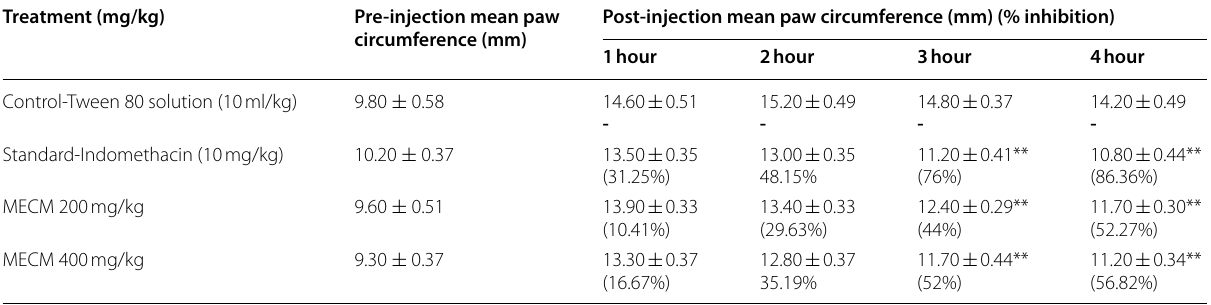
MECM Methanolic extract of seeds, SEM Standard error of the mean All values are expressed as Mean ** p < 0.01, *** p < 0.001 were considered statistically significant compared to